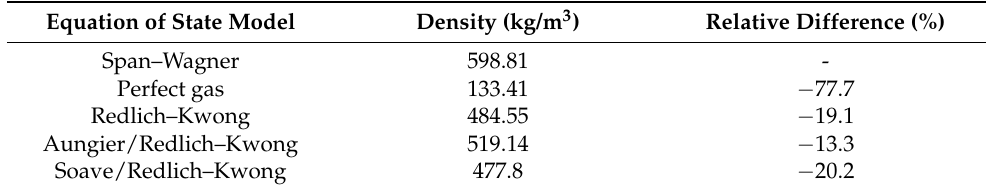
Table 7. Relative difference in CO 2 density between Span–Wagner model and various EOS models for conditions of 7.69 MPa and 304.3